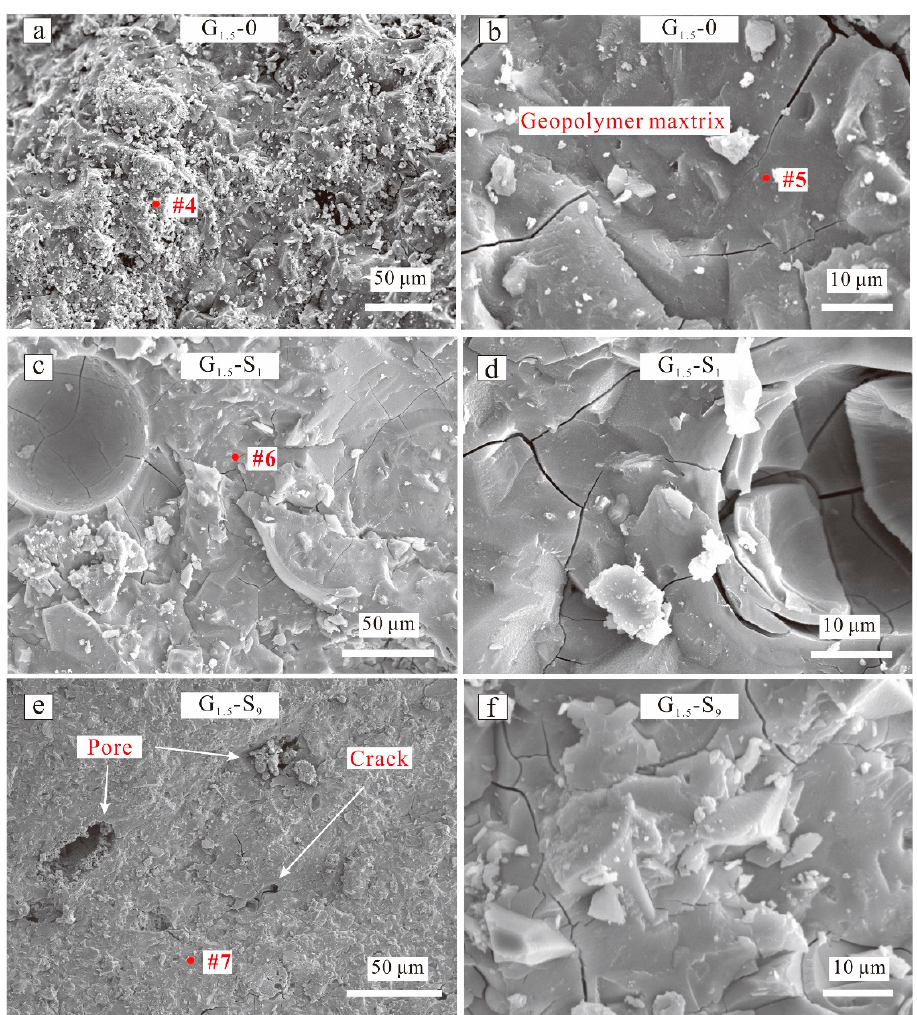
Figure 9. SEM images of Na 2 SiO 4 -activated geopolymers of ( a ) G 1.5 -0, ( c ) G 1.5 -S 1 , ( e ) G 1.5 -S 9 at low magnification; SEM images of Na 2 SiO 4 -activated geopolymers of ( b ) G 1.5 -0, ( d ) G 1.5 -S 1 , ( f ) G 1.5 -S 9 at high magnification.